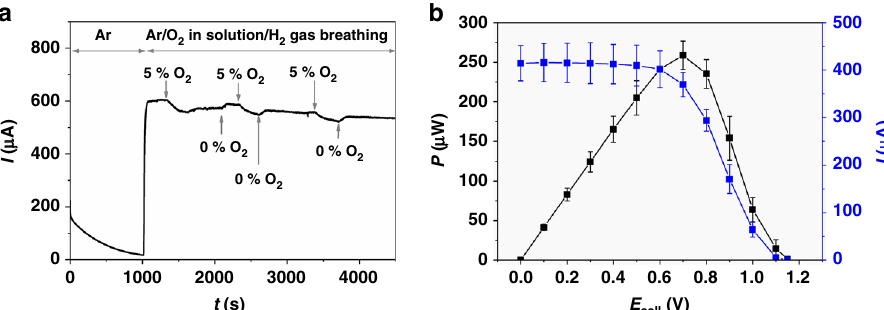
Fig. 3 Protection and performance of the bioanode. Protection of Dv MF-[NiFe] from O 2 at the bioanode ( a ) and power output of the Dv MF-[NiFe]/ Mv - BOD-based biofuel cell ( b ) in 0.1 M phosphate buffer (pH 7.4). a : Chronoamperometry of a P(GMA-BA-PEGMA)-vio//P(N 3 MA-BA-GMA)-vio/ Dv MF- [NiFe] bioanode at an applied potential of + 0.16 V (vs. standard hydrogen electrode) and in H 2 breathing mode. The solution was purged with Ar (100%) or Ar/O 2 (95%/5%). b Power curve showing absolute power P and absolute current values I for a H 2 /O 2 biofuel cell comprising a P(GMA-BA-PEGMA)- vio//P(N 3 MA-BA-PEGMA)-vio/ Dv MF-[NiFe] bioanode and the Mv -BOx biocathode measured with stepped potential chronoamperometry and in breathing mode. Average values for P and I calculated from three independent experiments are shown; error bars represent standard deviation. Source data are provided as a Source Data fi le. The maximum power output was determined to be 260 µ W at 0.7 V. The cell reveals an open circuit voltage of (1.13 ± 0.03) V. Nominal hydrogenase loading (absolute value per bioanode/normalized by the area of bioanode): 1.8 nmol/14.3 nmolcm − 2 . P(N 3